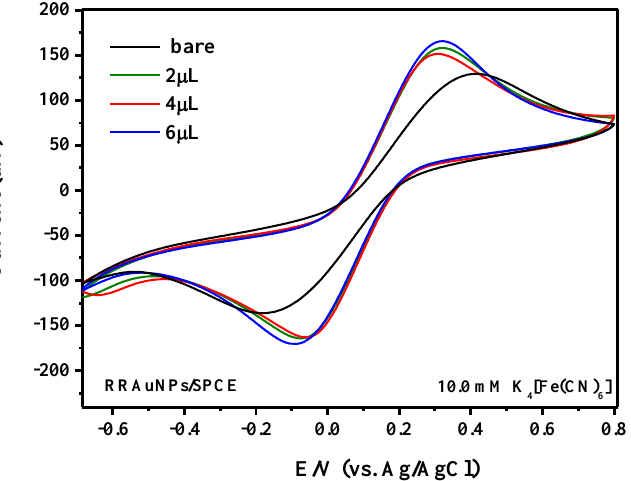
Figure 10. Cyclic voltammograms of bare SPCE and modified SPCE with different loading of dipped AuNPs. Scan rate 50.0 mV/s in 0.1 M PBS solution containing 10.0 mM K 4 [Fe(CN) 6 ].